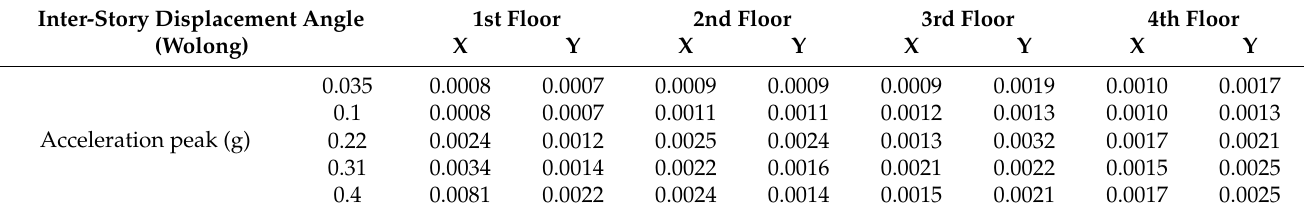
Table 8. Inter-story displacement angle